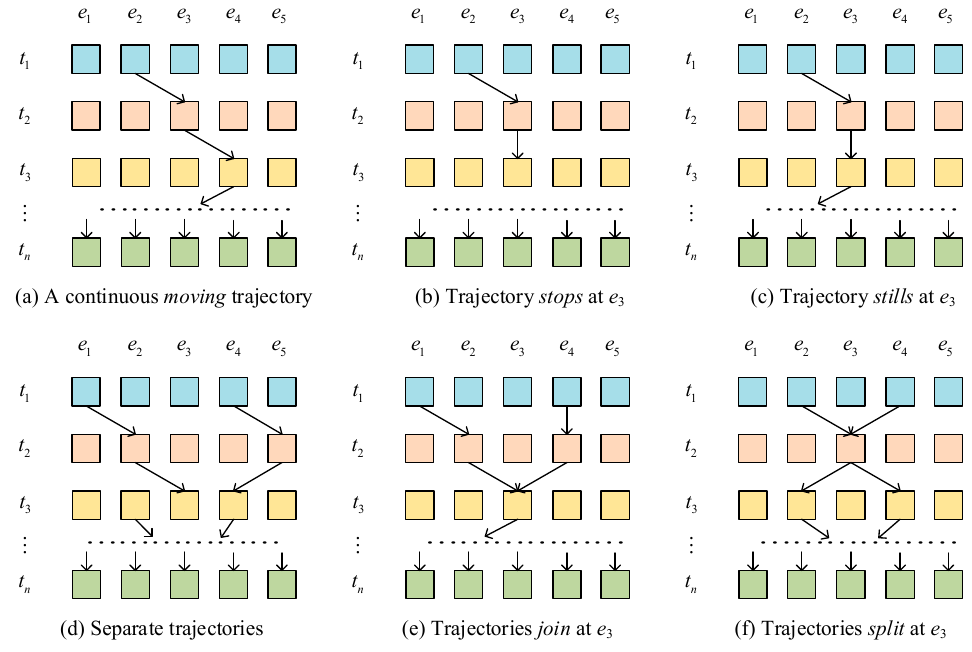
Figure 5. Different situation of the trajectory tracking.